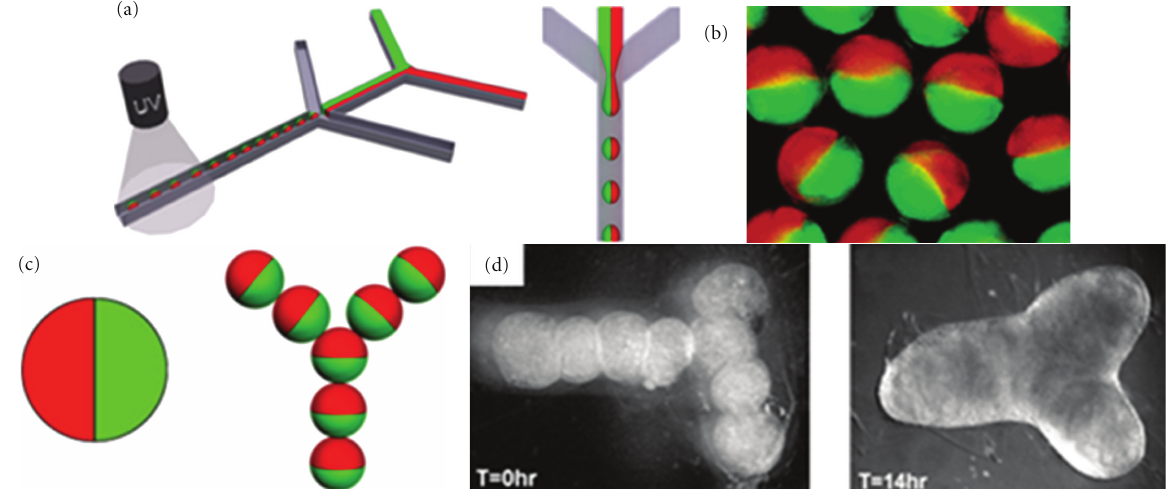
Figure 5: Fabrication of janus-like self-assembling tissue spheroids with magnetic nanoparticles. (a) Scheme demonstrating biofabrication of janus-like tissue spheroids using microfluidics [51]; (b) Janus-like spheroids fabricated by microfluidics devices [51]; (c) Scheme demonstrating magnetic-forces-driven self-directed self-assembly of closely placed janus-like magnetic tissue spheroids; (d) Branched structure formed as a result of fusion of closely placed tissue spheroids